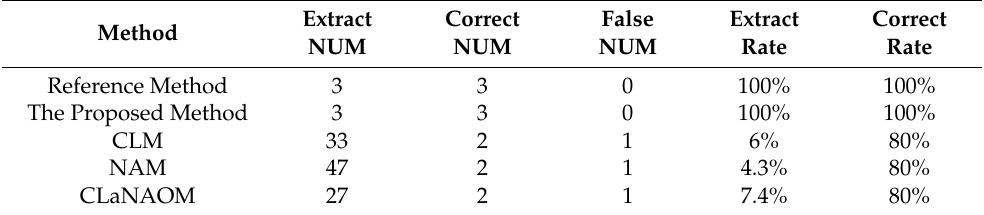
Table 13. The mountain vertices extraction results for each method using the fourth dataset.